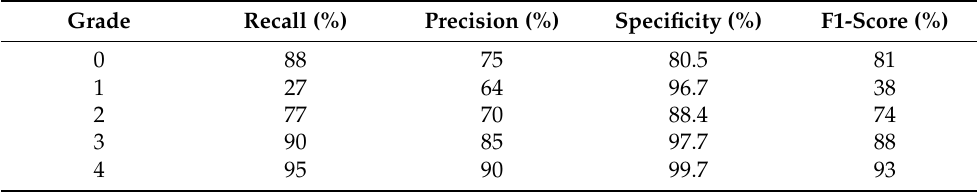
Table 4. The test set performance of our proposed DHL-I applied to the unseen dataset.